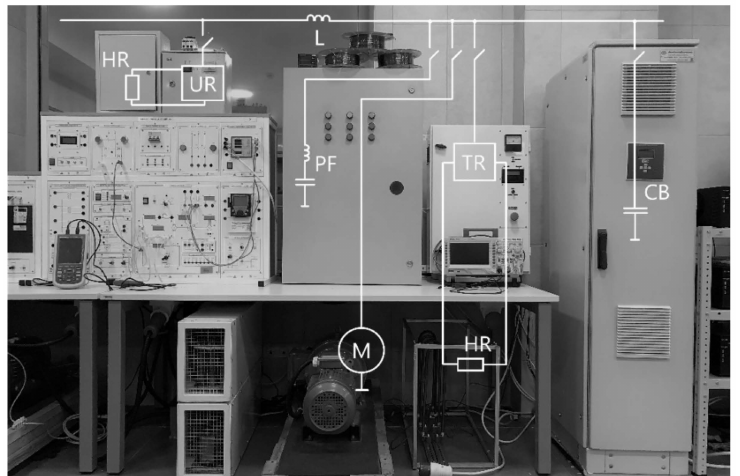
Figure 4. The single line scheme and test bench